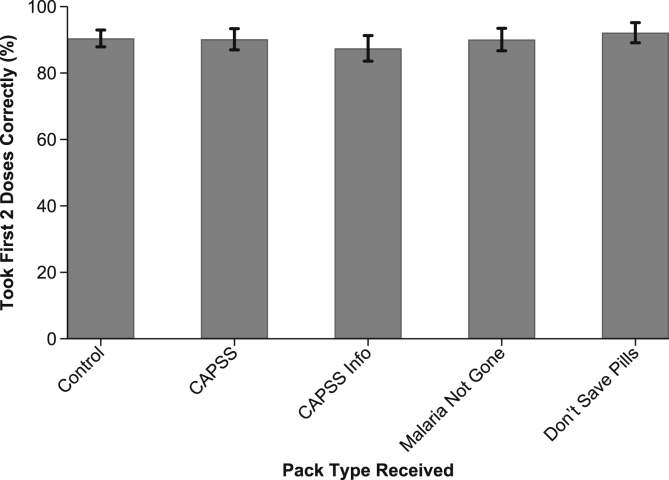
Timely adherence for First 2 Doses. We use the time that people took their first dose to construct a variable for whether each subsequent dose was taken at the correct time, and using the correct number of pills. Timings are approximate (morning, afternoon, evening). Sample is limited to those who started taking the medication.